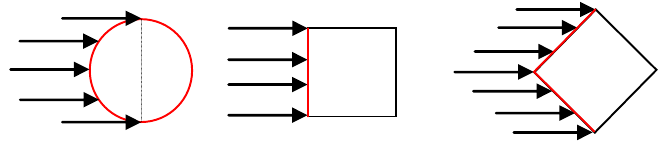
Figure 3. Proposed “shape of influence” parameter for structures.